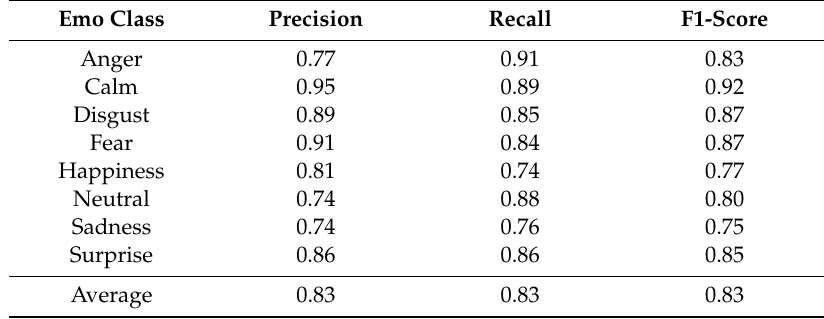
Table 4. Cross-corpus emotion recognition result using proposed fine-tuning method on RAVDESS.